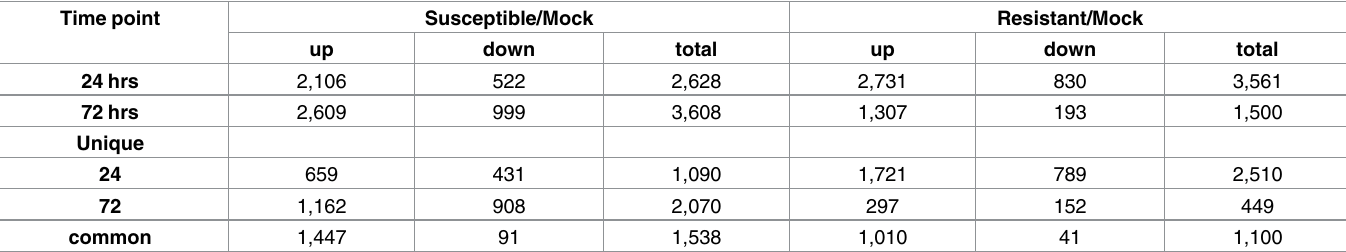
Table 2. Counts of differentially expressedgenes in cv.